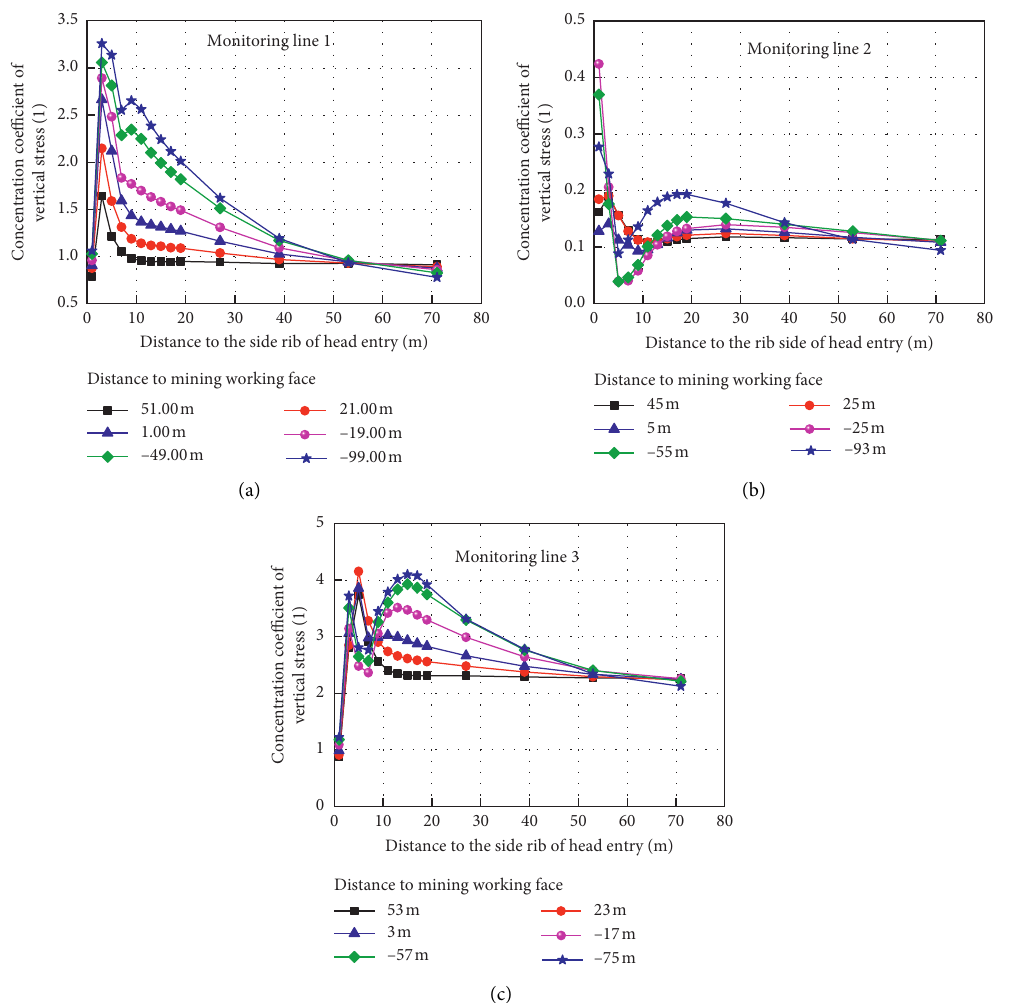
Figure 8: Concentration coefficient of abnormal stress in lateral of the mining working face. (a) Monitoring line 1, (b) monitoring line 2, and (c) monitoring line